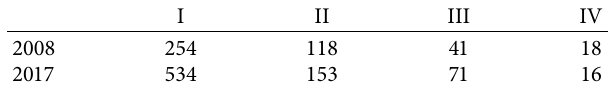
Table 3: Scale grade of secondary schools in Liaoning Province in 2008 and